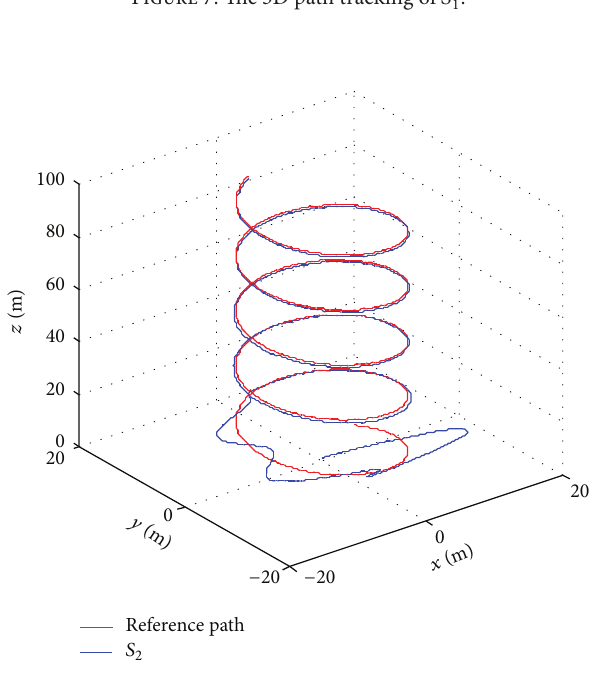
Figure 7: The 3D path tracking of 𝑆 1 .